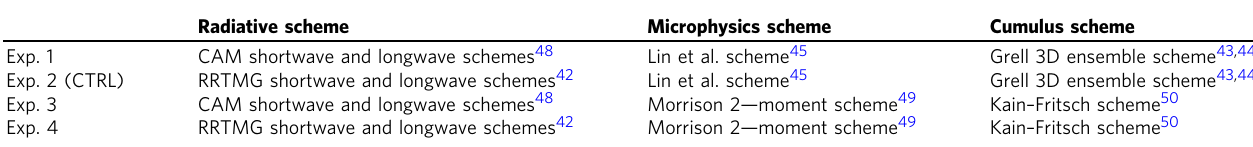
Table 1 Radiative, microphysics, and cumulus schemes used in the multi-physics ensemble of WRF simulations. We denote as CONTROL (CTRL) con fi guration the one corresponding to Exp.